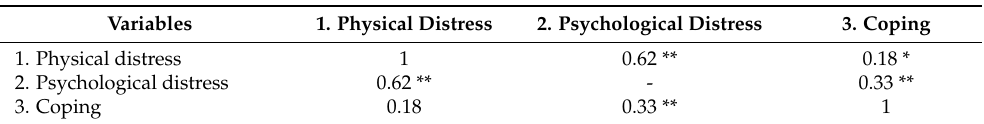
Table 2. Correlation between physical distress, psychological distress, and coping among people infected with COVID-19 (n =